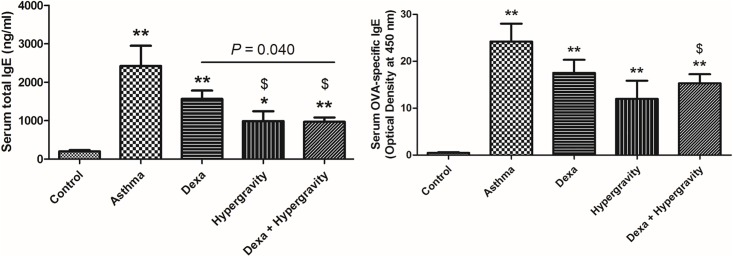
Serum levels of total IgE and ovalbumin (OVA)-specific IgE.* Significant difference from the control group, p < 0.05; ** significant difference from the control group, p < 0.01; $ significant difference from the asthma group, p < 0.05 (the Kruskal-Wallis and Mann-Whitney U tests).